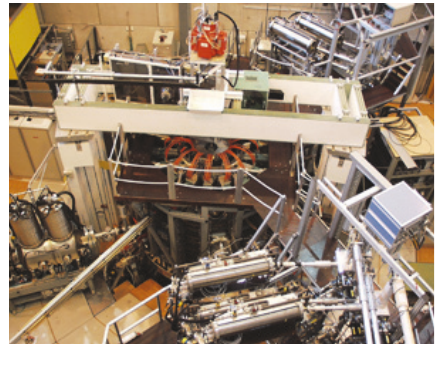
Figure 1: D-T fusion reaction. Figure 2: TCV reactor.